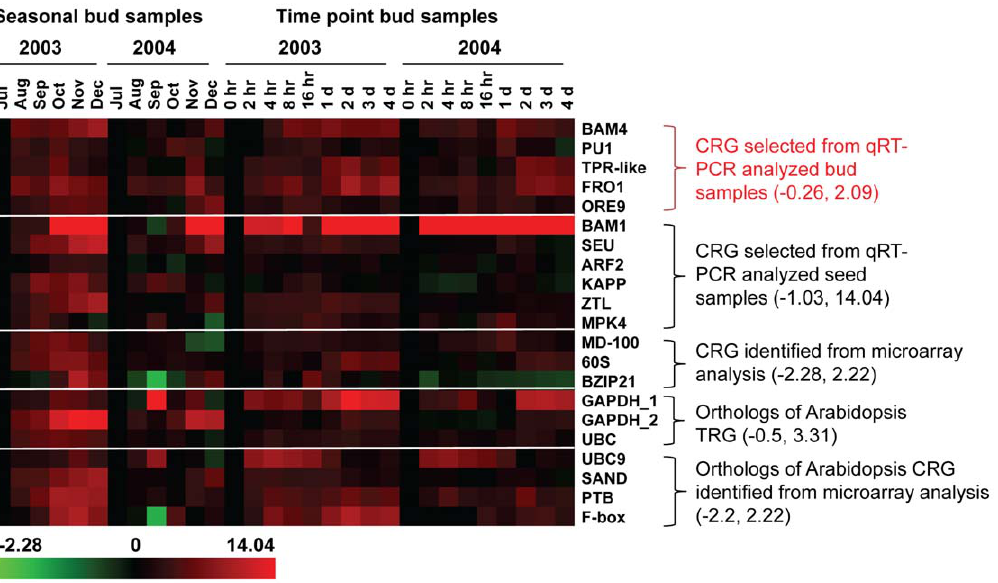
Figure 1. Candidate reference genes examined in bud samples. Two sets of seasonal bud samples (2003 and 2004) and two sets of time point bud samples (2003 and 2004) were used to examine gene expression. The fold difference is designated as log2 value. Red indicates up-regulated genes and green indicates down-regulated genes as compared with July or 0 hr buds (black). Bars at the bottom indicate the range of transcript changes in log2 value. The range of transcript changes is also shown inside the parenthesis. CRG: Candidate Reference Genes. TRG: Traditional Reference Genes.